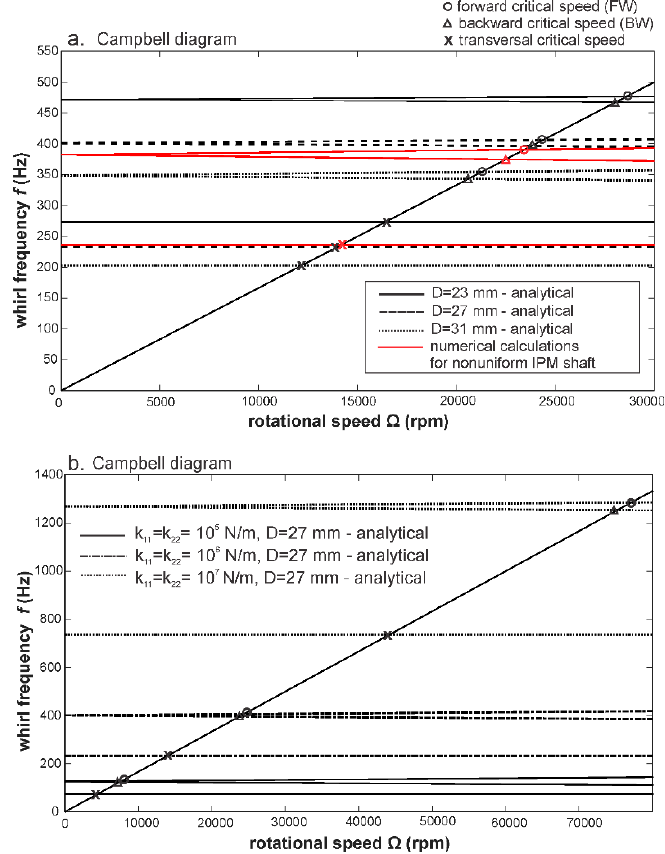
Figure 13. Comparison of Campbell diagrams and critical speeds: ( a ) analytically calculated for different shaft diameters and the numerical results for the real non uniform IPM motor shaft geometry (all the calculations are done for the bearings stiffness k 11 = k 22 = 10 6 N/m) and ( b ) analytically calculated for different properties of bearings (all shafts are L = 207.5 mm long). Table 5. Comparison of analytical and numerical results (IPM shaft with k 11 = k 22 = 10 6 N/m, L = 205.7 mm).